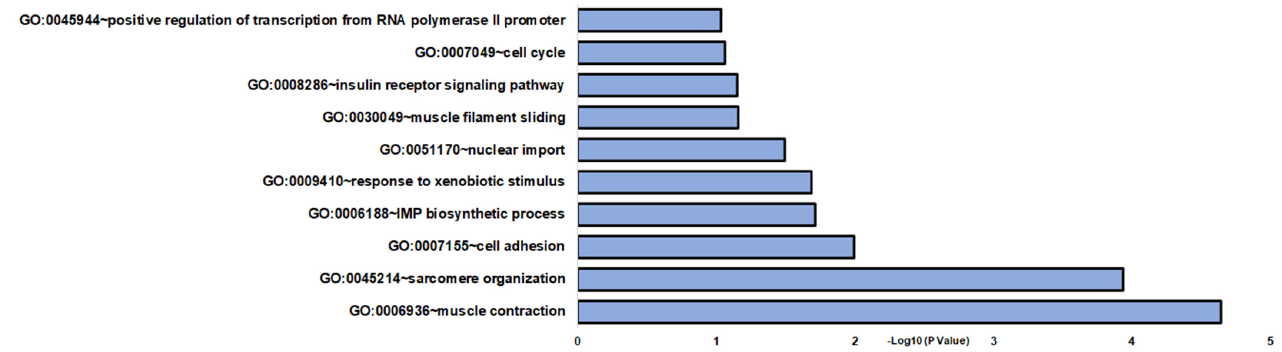
Figure 2. Gene enrichment analysis of biological processes in vehicle and DOC DETs. The graph indicates the − log 10 ( p -value) enriched BPs of differentially expressed transcripts between the vehicle and DOC groups with p -values < 0.05.